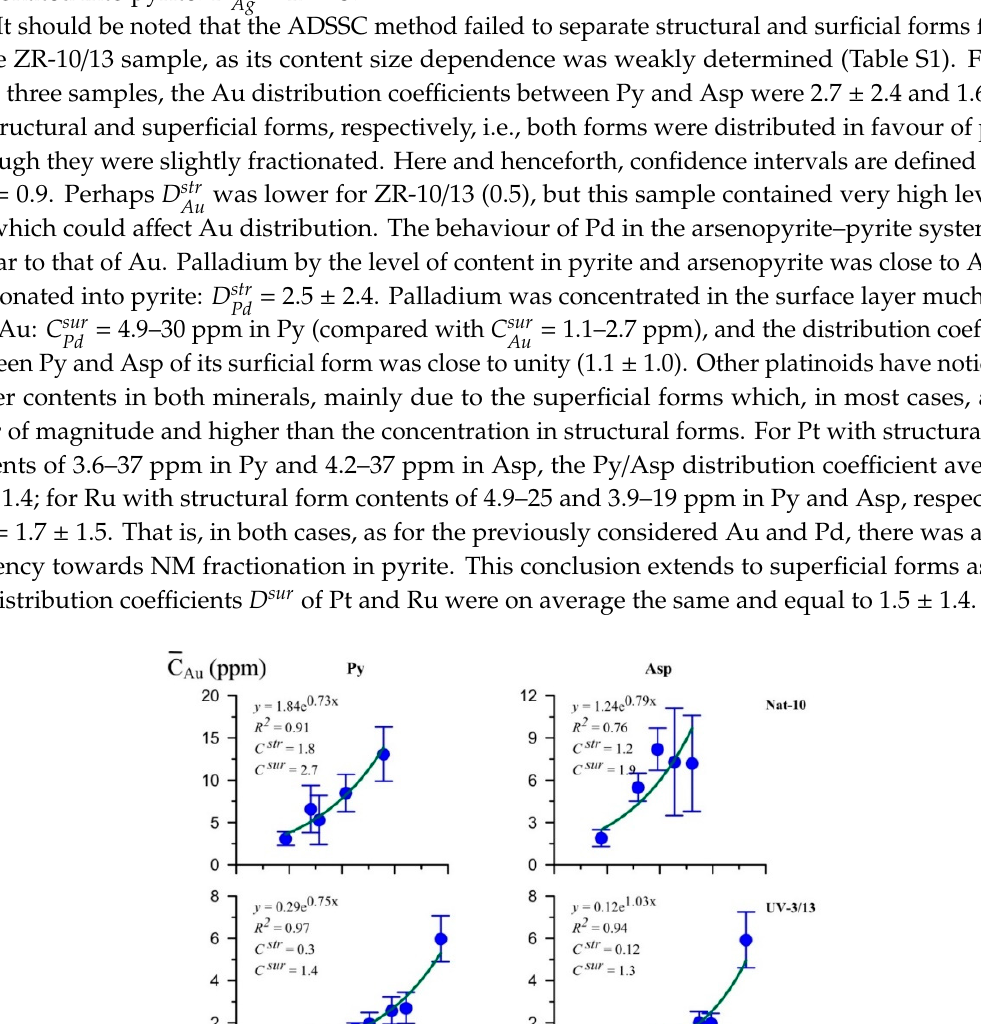
Figure 6. Dependence of the average concentration of evenly distributed Pd in pyrite and arsenopyrite on the specific surface area of an average crystal in size fraction. See Figure 5 for explanations.